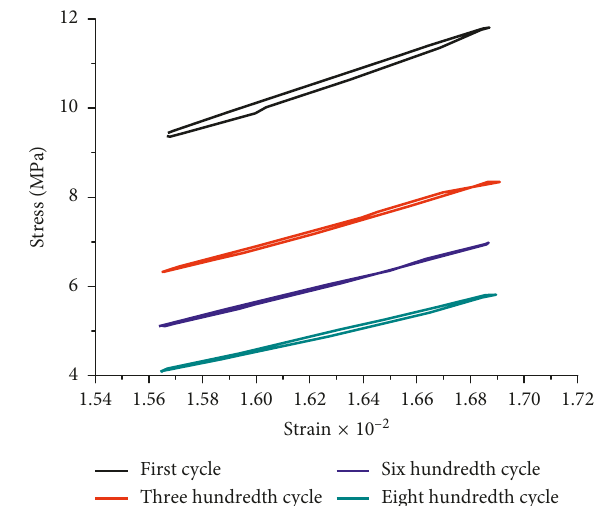
Figure 11: Change in hysteresis loop after the increase of dis- turbance